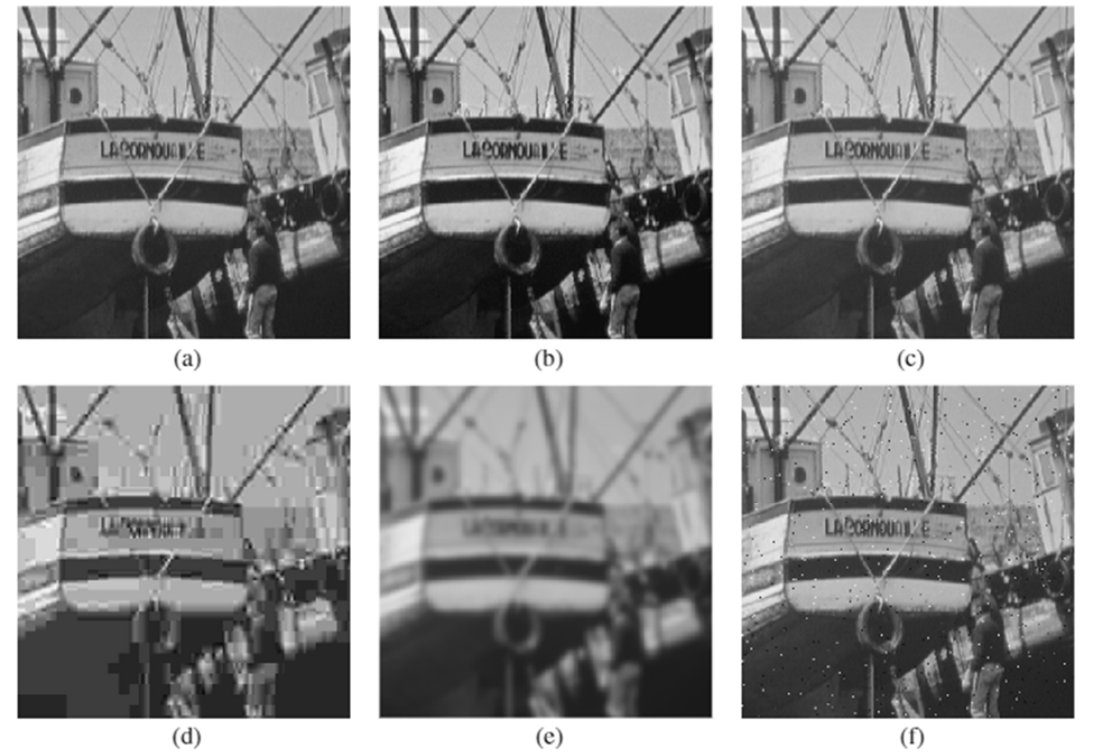
Figure 4. Comparison of the same image with the same MSE = 210 but different sources of degra- FIGURE 1. Comparison of “Boat” images with different types of distortions, all with dation: ( a ) Original image (8 bits/pixel, cropped from 512,512 to 256,256 for visibility); ( b ) contrast- MSE=210. (a) Original image (8 bits/pixel; cropped from 512512 to 256256 for visibility). stretched image, MSSIM = 0:9168; ( c ) mean-shifted image, MSSIM = 0:9900; ( d ) JPEG compressed (b) Contrast-stretched image, MSSIM=0:9168. (c) Mean-shifted image, MSSIM=0:9900. (d) image, MSSIM = 0:6949; ( e ) blurred image, MSSIM = 0:7052. ( f ) salt-pepper impulsive noise- JPEG compressed image, MSSIM=0:6949. (e) Blurred image, MSSIM=0:7052. (f) Salt- contaminated image, MSSIM = pepper impulsive noise contaminated image, MSSIM=0:7748.